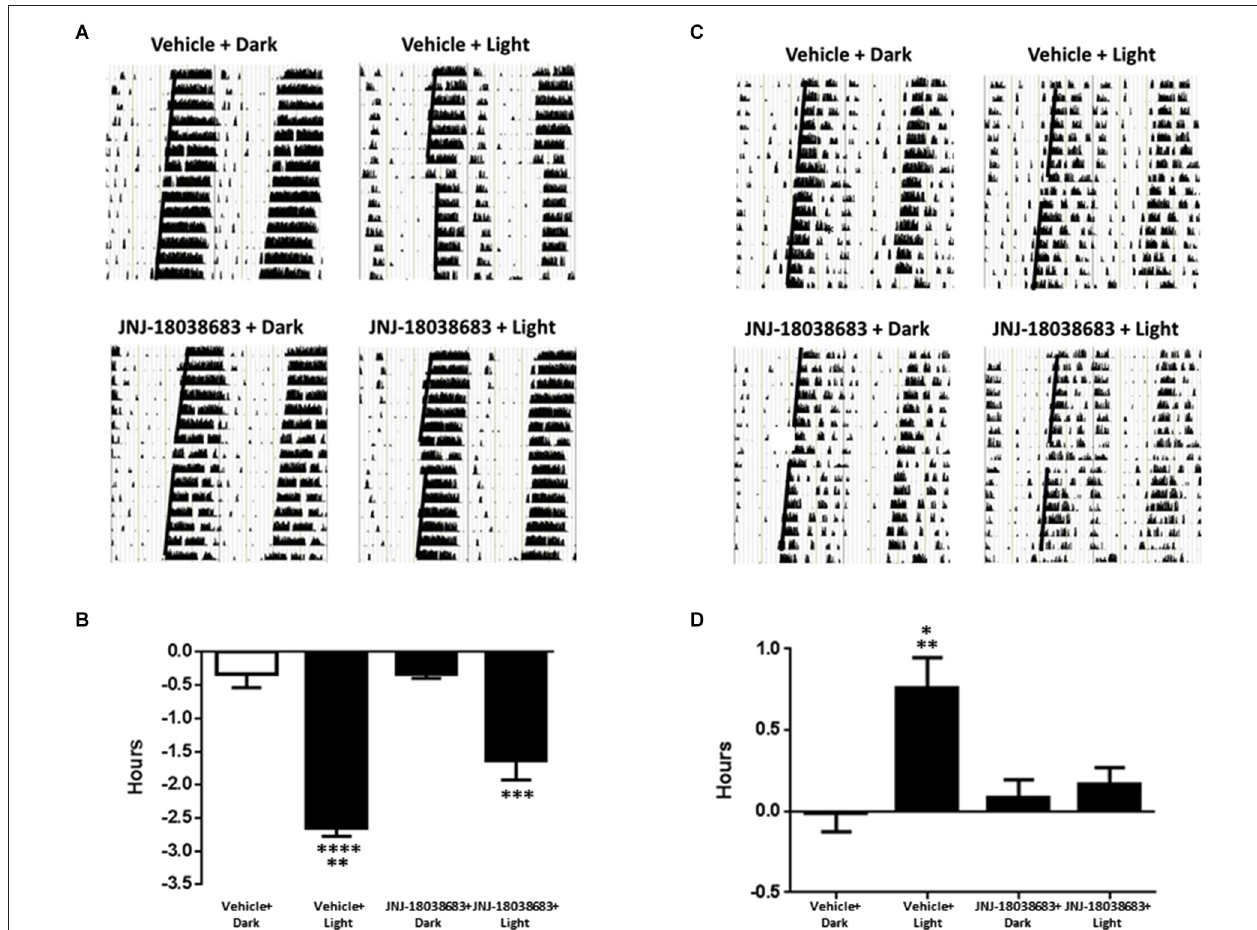
shifts of locomotor activity (onsets of activity indicated by bold black line) were calculated based upon the onset of activity following treatment compared to prior treatment. Results are expressed as mean ± S.E.M. and a one-way ANOVA followed by a Tukey’s post hoc test was performed to determine if a result was significant (Phase Delay—** p < 0.01 vs. JNJ-18038683 + Light, *** p < 0.001 vs. JNJ-18038683 + Dark, **** p < 0.0001 vs. Vehicle + Dark and JNJ-18038683 + Dark; Phase Advance—* p < 0.05 vs. JNJ-18038683 + Light, ** p < 0.01 vs. Vehicle + Dark and JNJ-18038683 +